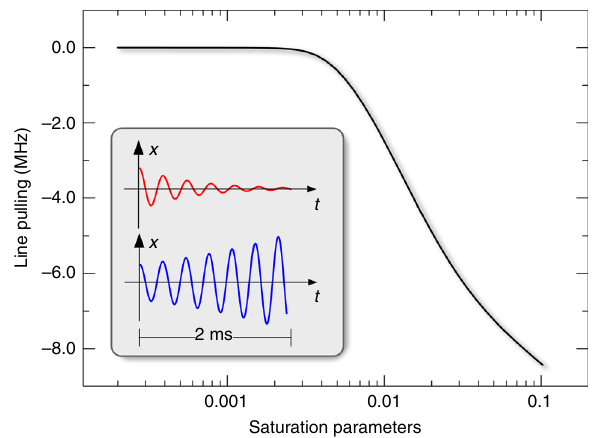
Fig. 5 Line pulling due to heating/cooling of the spectroscopy laser. The radiation pressure of the cooling laser misplaces the ion out of its potential minimum by x ≈ 2 μ m. Sudden termination of the cooling laser sets the ion in motion. Depending on the detuning of the spectroscopy laser this oscillation is either damped or ampli fi ed (see inset , not to scale). The dynamics is modeled numerically and the fl uorescence signal is determined for different detunings of the spectroscopy laser. The resulting slightly asymmetric line shape is then fi tted by a Lorentzian to measure the line pulling due to this effect. The saturation parameter measures the laser intensity I through s = I / I s with I s = 250 mW cm − 2